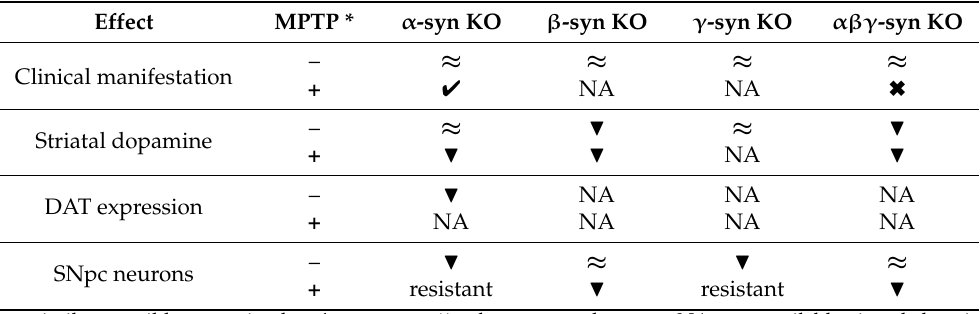
Table 2. Main phenotypic changes in synuclein-knockout animals before and after MPTP injections.